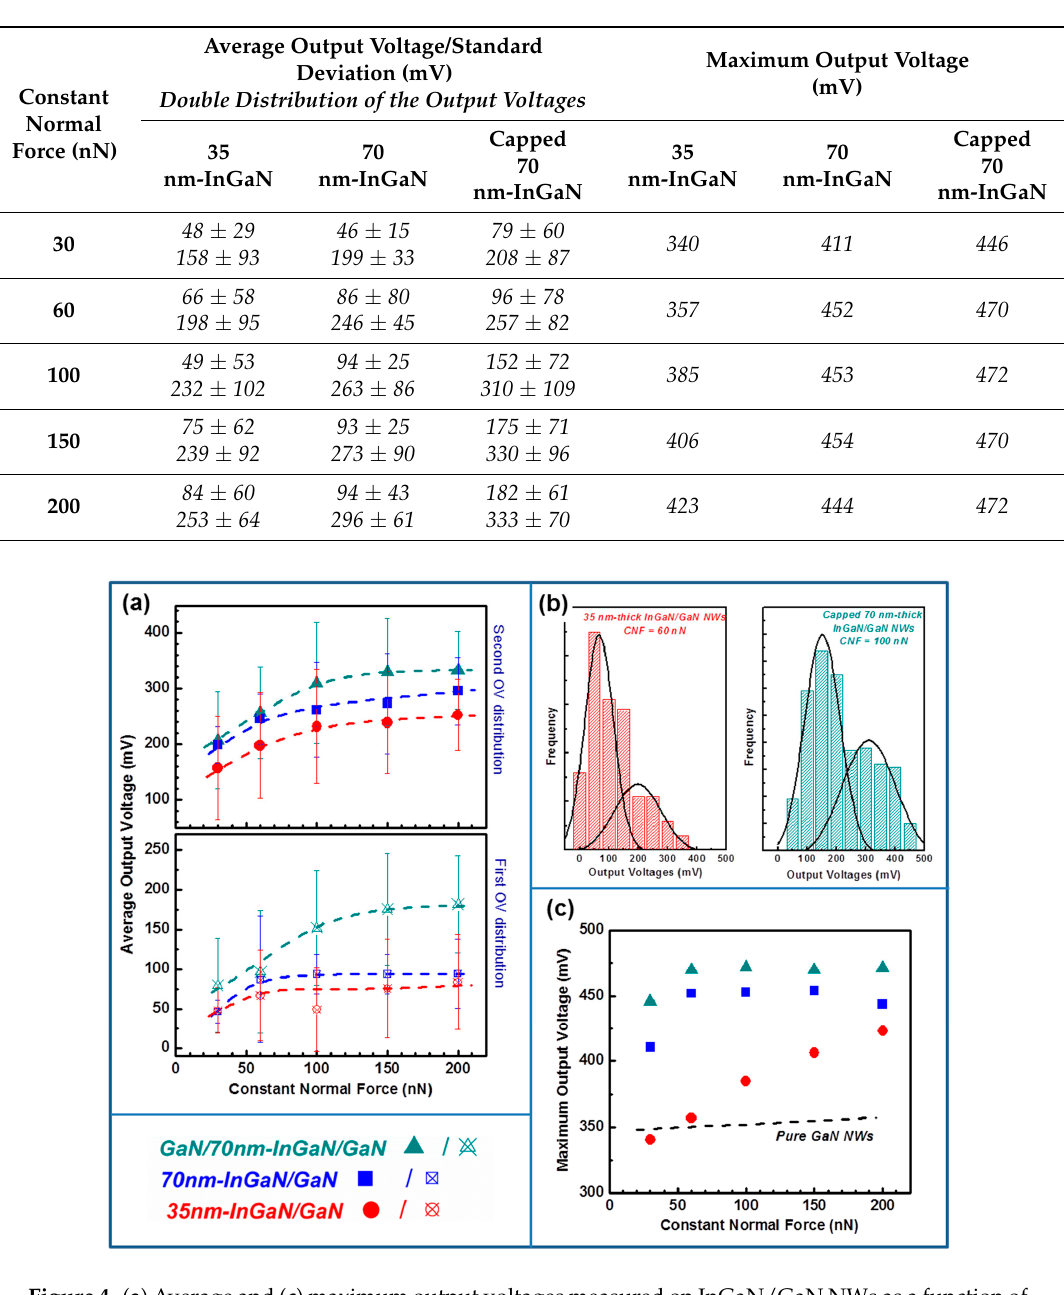
Table 1. Average values, standard deviations and maximal output voltages (with a measurement precision of 2%) generated by NWs as a function of the constant normal force.